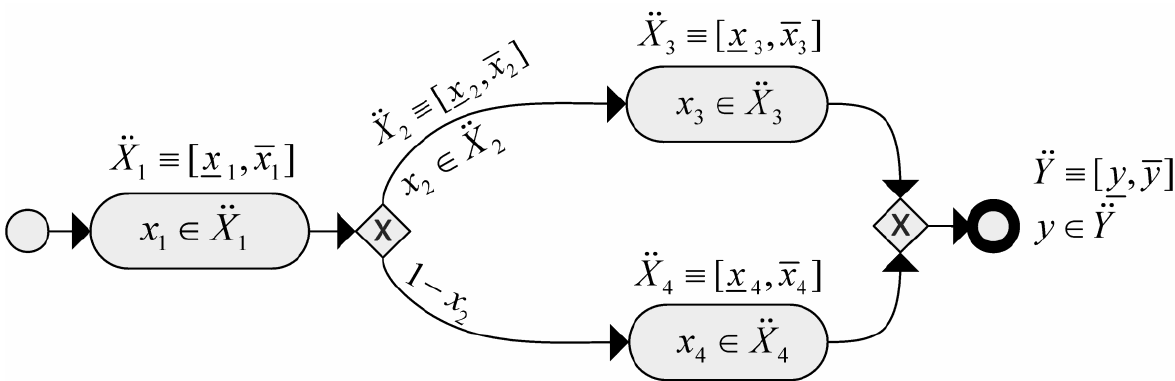
Figure 6. A simple case of interval-valued BPMN